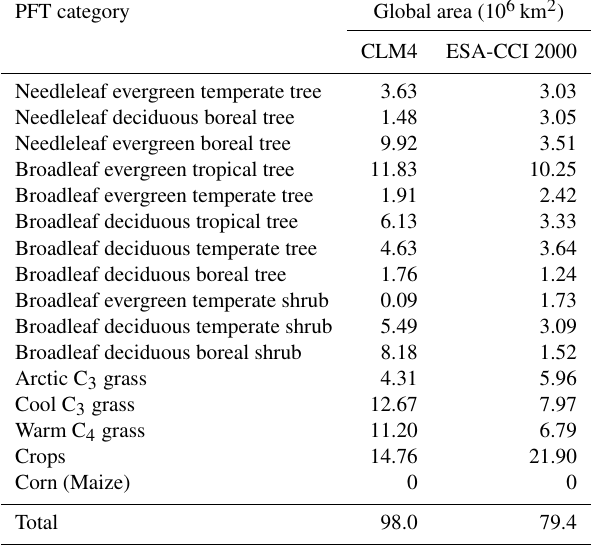
Table 1. List of MEGANv2.1 PFT categories and global coverage by each PFT category (10 6 km 2 ) according to CLM4 and ESA-CCI (year 2000) land cover